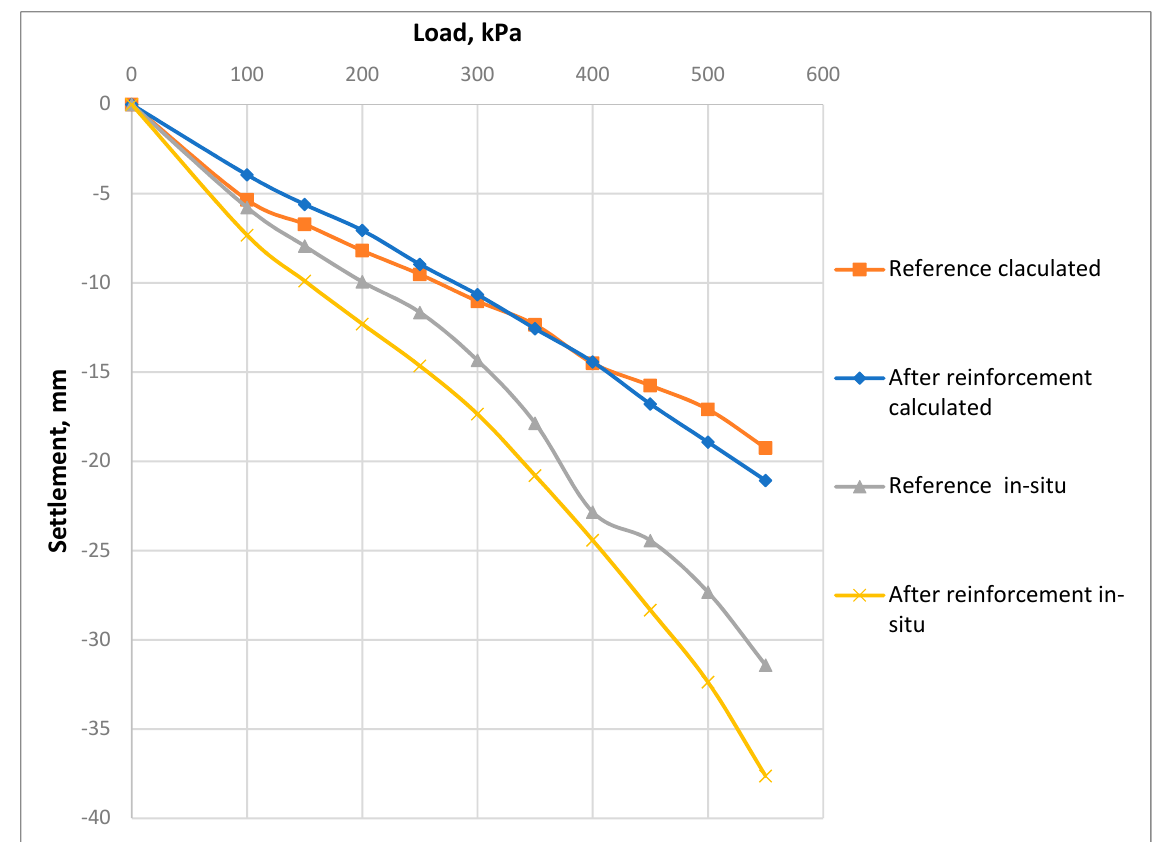
Figure 11. The averaged load − settlement curve of all investigated in situ samples, compared with the averaged theoretical calculation results before and after the reinforcement process.